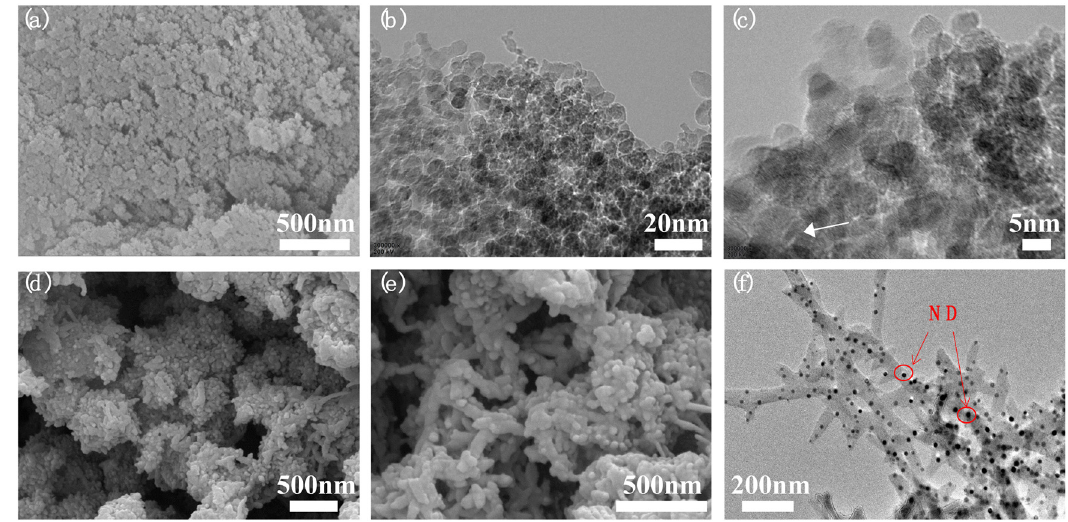
Figure 3: ( a ) SEM image of original ND, ( b ) TEM image of original ND and ( c ) related HR - TEM image of ND, ( d ) SEM image of PANi/ND, ( e ) SEM image of PANi/ND with further enlargement and ( f ) TEM image of PANi/ND.